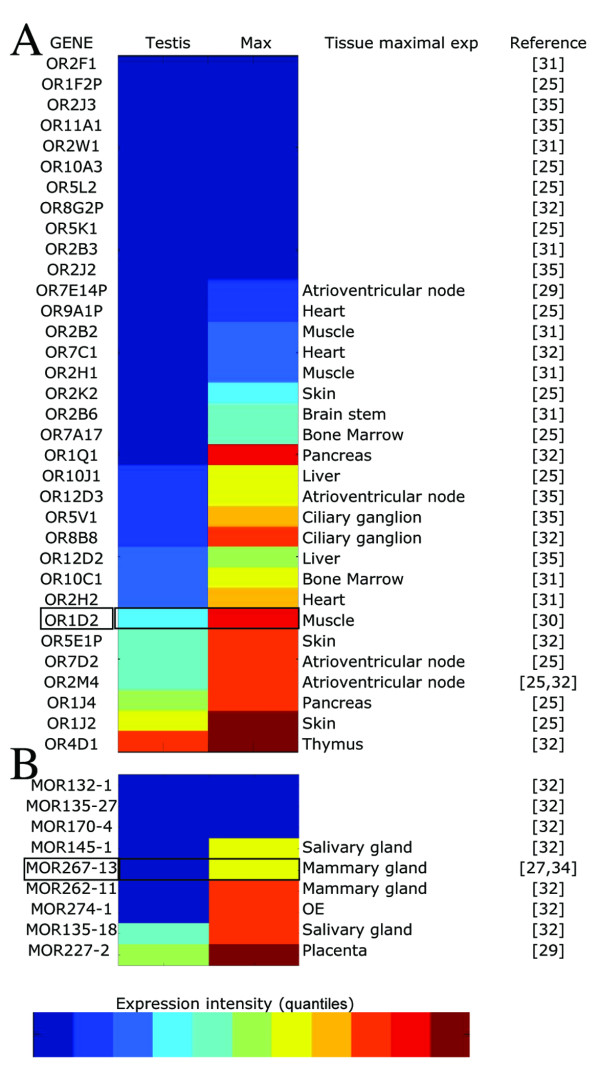
Ectopic expression of OR genes in testis and in the tissue of maximal (Max) expression. A. 34 human and B. 9 mouse ORs were represented in the GeneAtlas2 microarrays out of the 53 human and 19 mouse ORs previously reported to be expressed in testis or sperm. The OR gene symbols in black rectangles were suggested to be implicated in sperm chemotaxis. In the column right to Max is the name of the tissue with the maximum expression intensity, if expression was detected in any tissue in quantile 1 or higher. Expression color scale as in Figure 2.